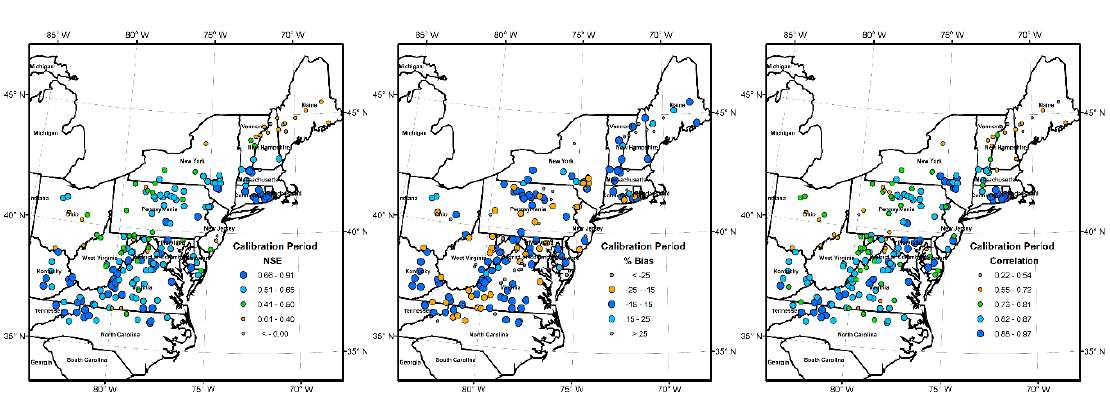
Figure 3. Nash Sutcliffe efficiency, percentage bias and correlation of smoothed daily streamflow for the calibration year 1980.